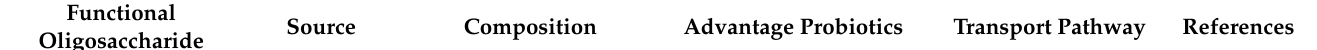
Table 2. Sources of common functional oligosaccharides and their mode of action with